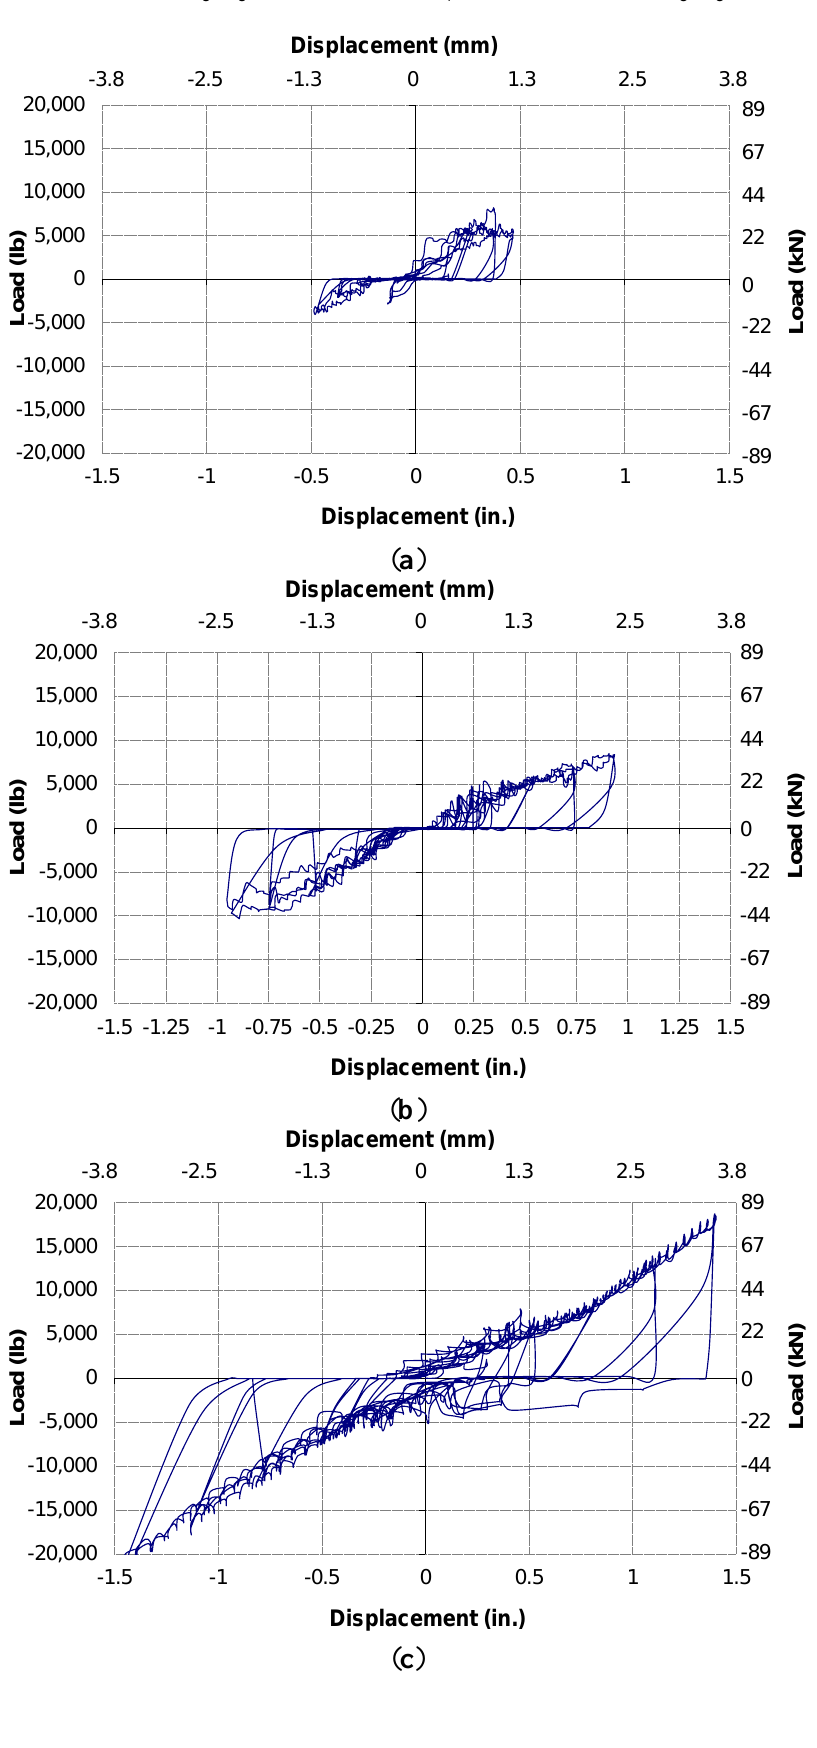
Figure 14. Test BFCT1 load-deflection hysteretic behavior. ( a ) BFCT1 1st story hysteretic behavior; ( b ) BFCT1 2nd story hysteretic behavior; ( c ) BFCT1 3rd story hysteretic